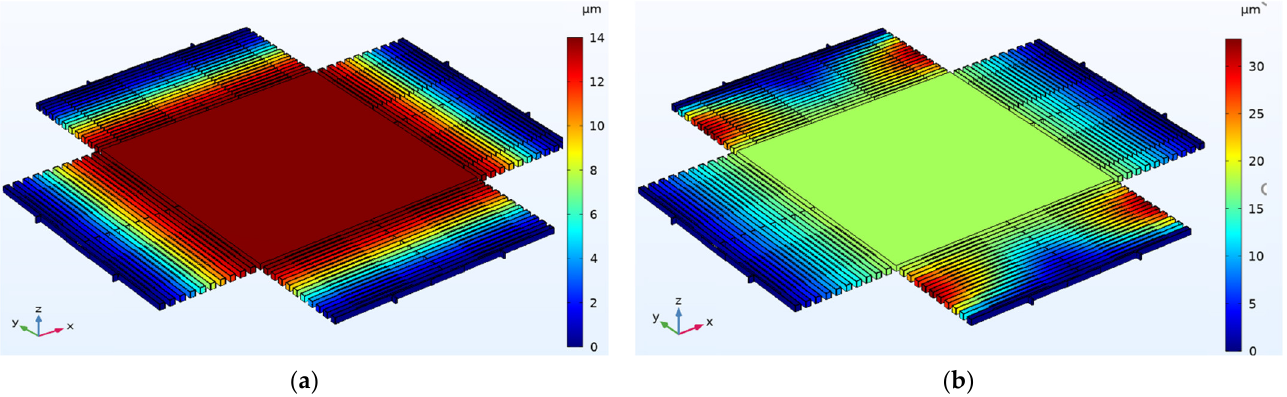
Figure 7. COMSOL simulation of design 3 for: ( a ) The vertical displacement (in z-direction) under 10 G acceleration, ( b ) the lateral displacement (in x-direction) under 10 G acceleration.